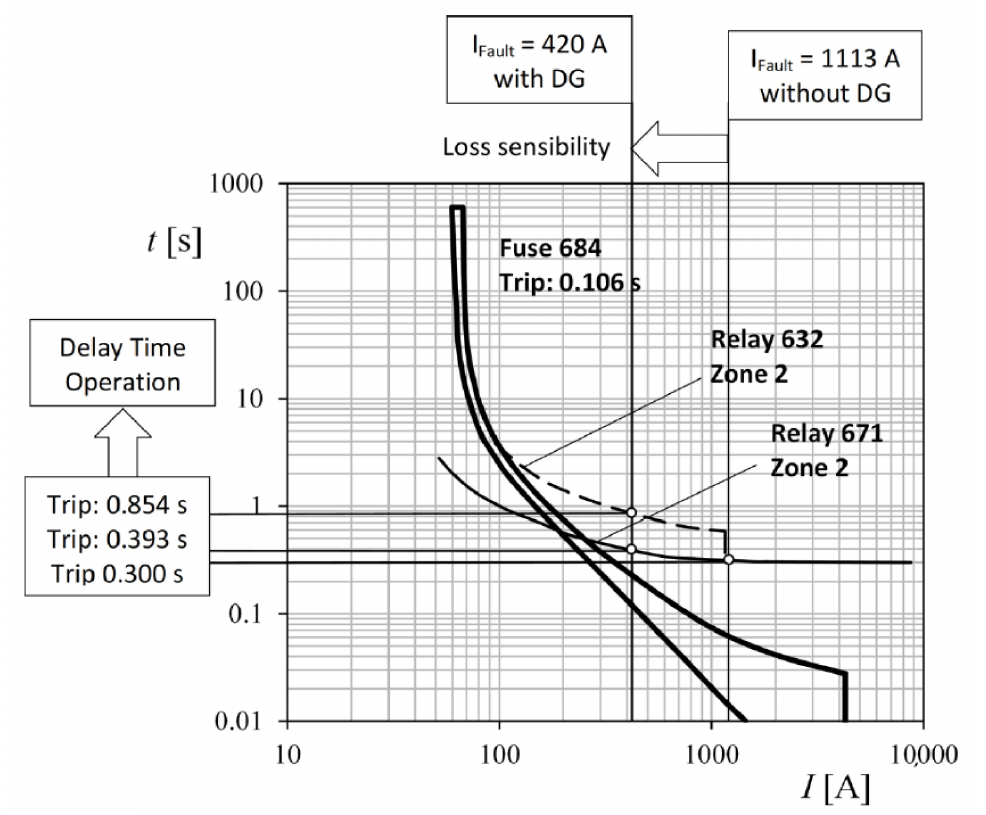
Figure 11. Protection Zone 3 current-time ( I-t ) performance in case of a three-phase short-circuit at point F1, with 25% DG power (1 MW) at bus 652 (see Figure